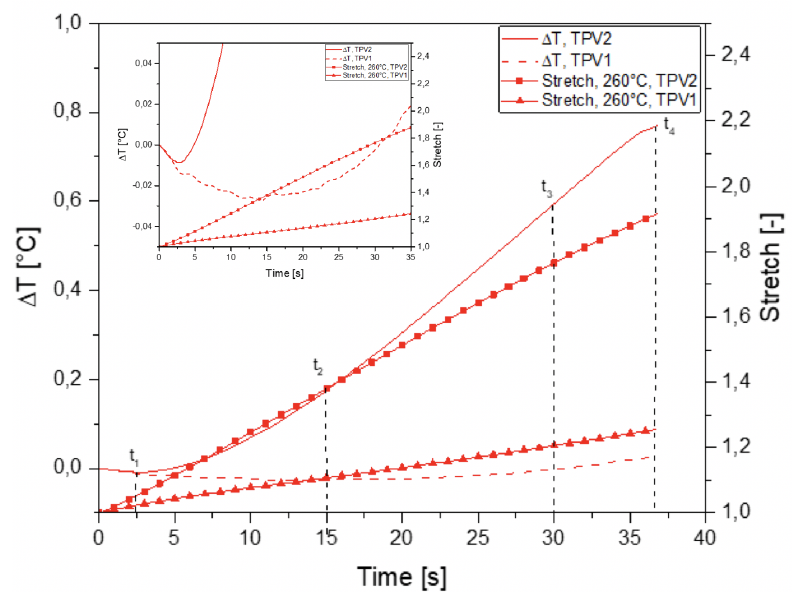
Figure 16. Temperature change with stretch for specimen overmoulded at 260 ◦ C, in the case of monotonic tensile test until